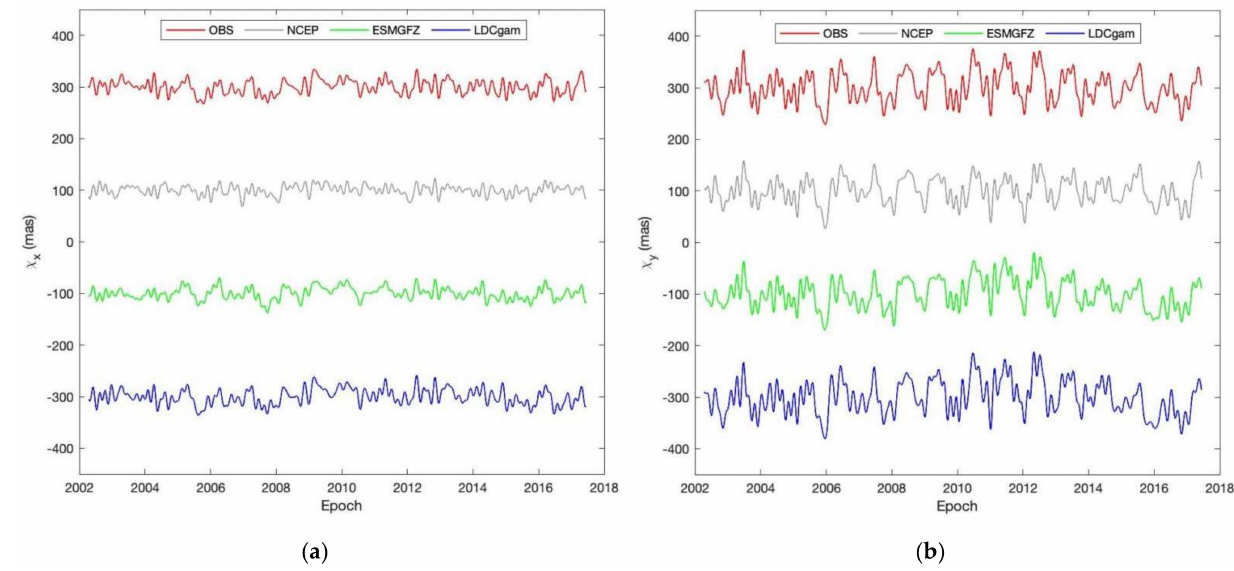
Figure 2. Time series of observed and geophysical excitations. ( a ) x-components; ( b ) y-components. The means, trends and high-frequency components (higher than 6 cycles per year) are removed for all series. These series are shifted vertically for better